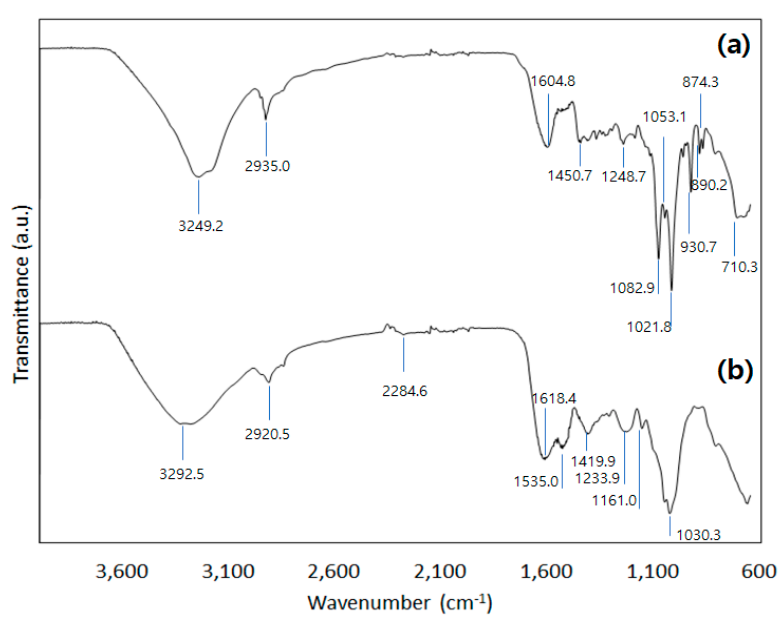
Figure 4. FTIR spectra of ( a ) H. fusiformis and ( b ) 1 M NaOH-treated H. fusiformis.